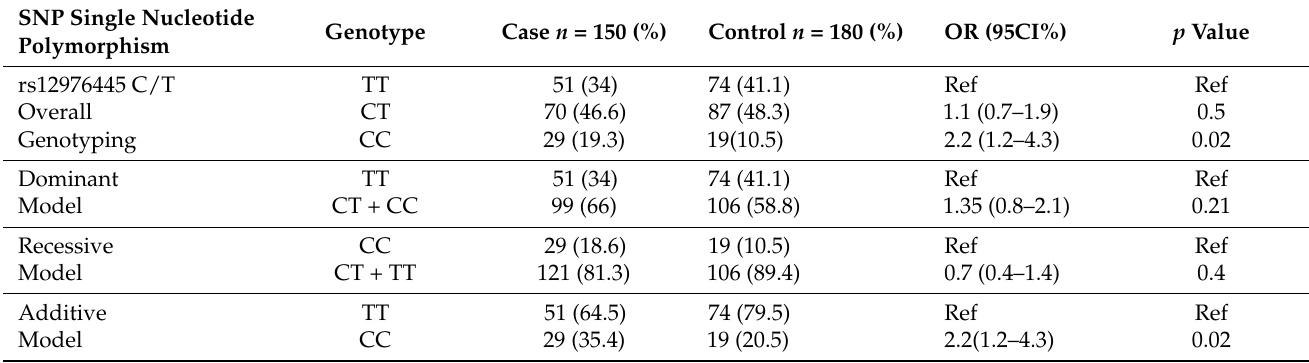
Table 1. Single nucleotide polymorphism (SNP) genotype distribution of miR-125a (rs12976445 C/T and rs10404453 A/G) and allele frequencies in RPL cases and control